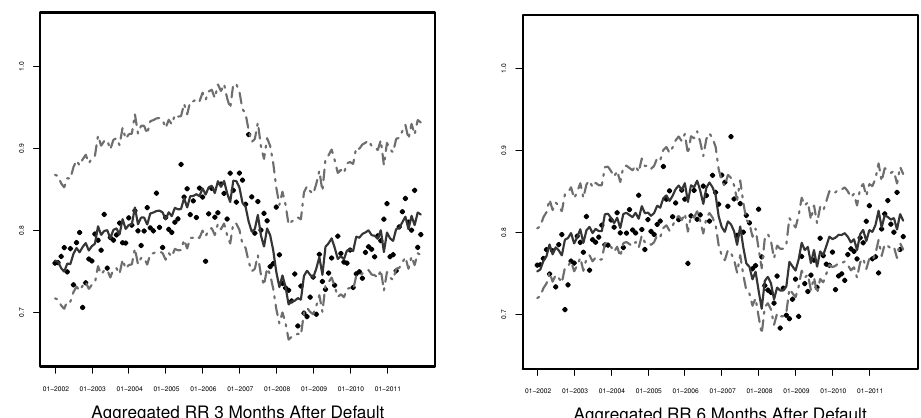
Figure 13. Monthly aggregated recovery rates with 99% prediction interval (grey dot-dash line) and the mean of the predictions (grey solid line) 3 and 6-months after default for Model (6).